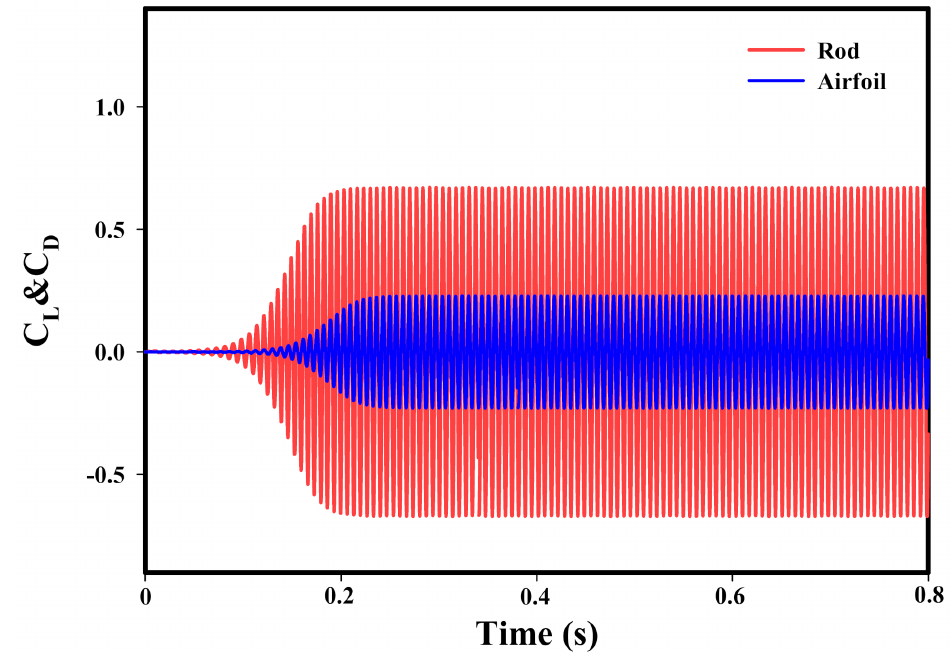
Figure 3. Time history of the lift coefficient of rod and airfoil.